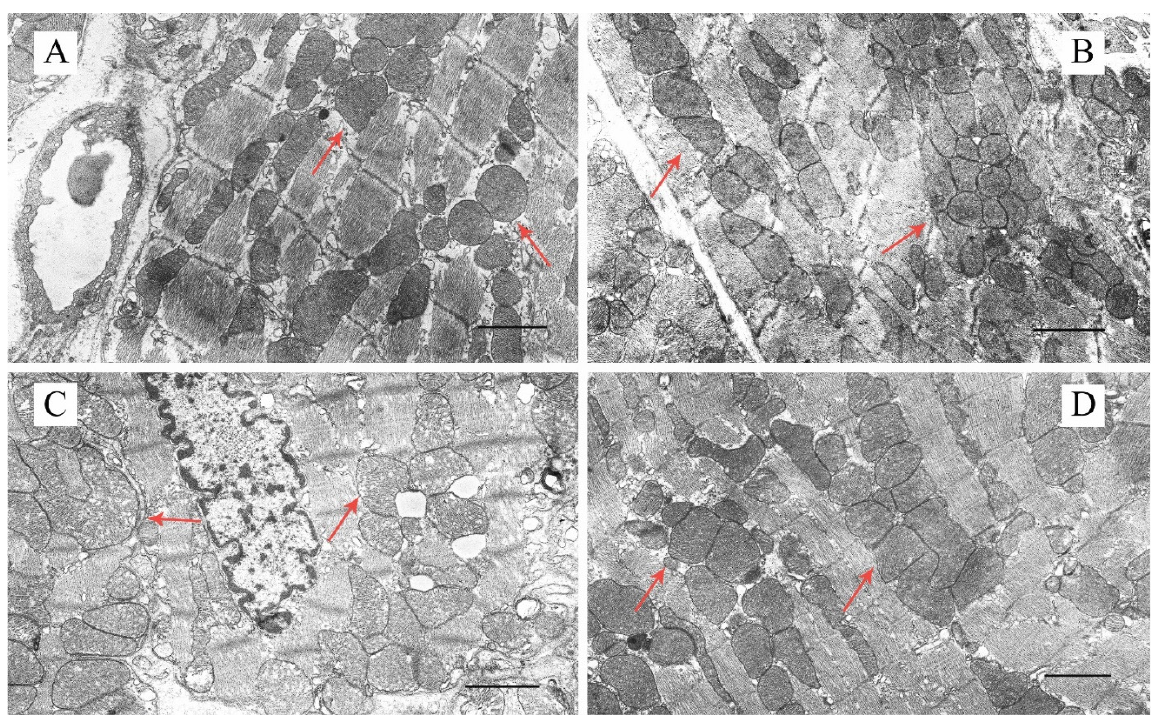
Figure 2. Representative transmission electron micrographs of mouse cardiomyocyte sections in the experimental groups: CTR ( A ), CTR + U ( B ), DM ( C ), and DM + U ( D ), showing the quality of the ultrastructure of cardiac intrafibrillar mitochondria. Images with ×5000 original magnification were taken from the basal inferior segment of the left ventricle of male C57BL/6NCrl mice. Red arrows indicate individual mitochondria. Scale bar: 1 μ m.